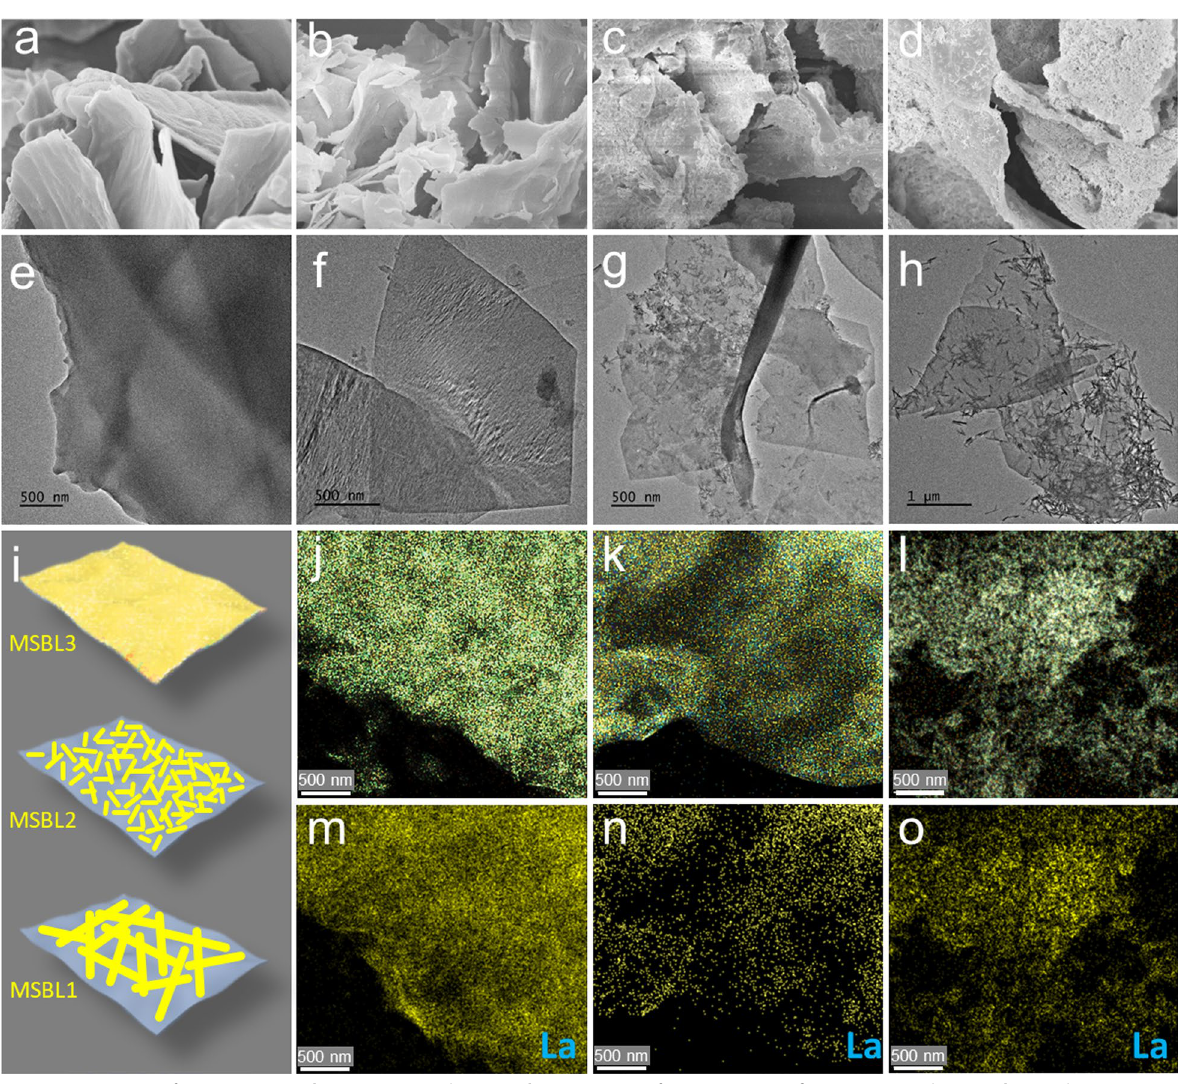
Fig. 2 SEM images of MSB ( a ), MSBL3 ( b ), MSBL2 ( c ), and MSBL1 ( d ); TEM images of MSB ( e ), MSBL3 ( f ), MSBL2 ( g ), and MSBL1 ( h ); ( i )